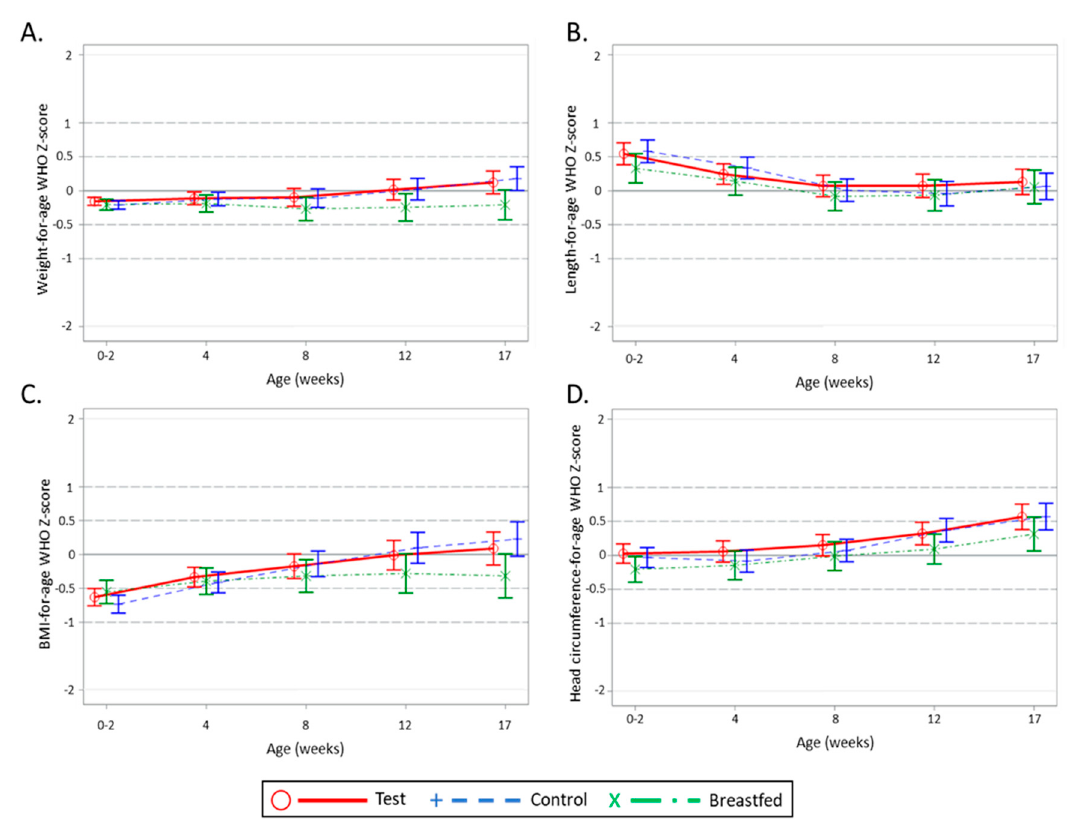
Figure 2. Estimated mean ( ± 95% CI) WHO Growth Standard z-scores weight-for-age ( A ), length-for-age ( B ), BMI-for-age ( C ), and head circumference-for-age ( D ) per visit for the Test, Control, and Breastfed reference groups. Per protocol population and Breastfed reference